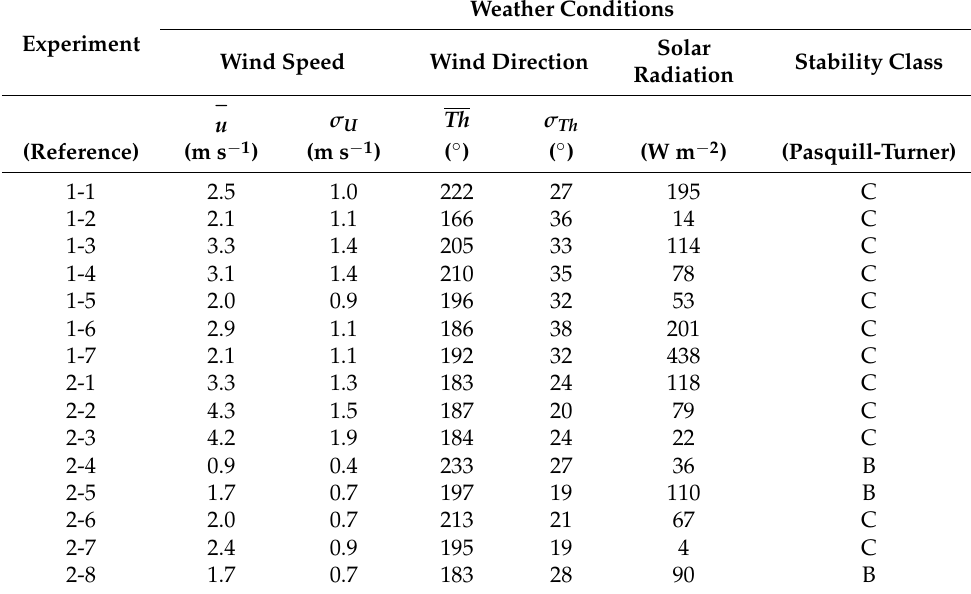
Table 2. Meteorological